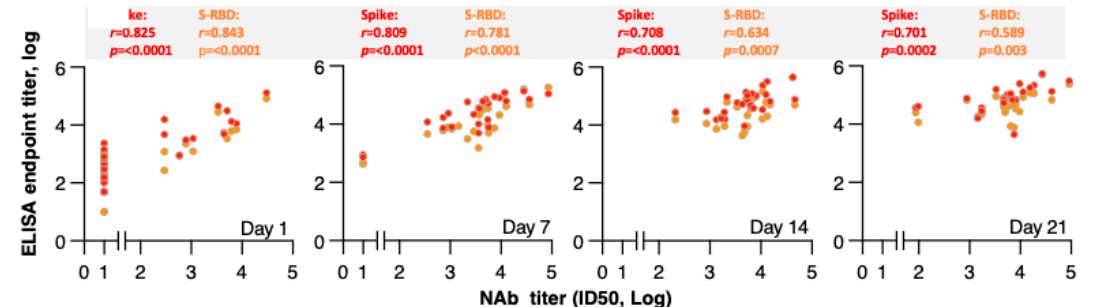
Figure 2. Correlations of the Spike and Spike-RBD binding and Neutralizing antibodies (NAb) at different time points. Correlations of reciprocal pseudotype NAb titers (ID50, log) and reciprocal endpoint titers of Spike (red symbols) and Spike-RBD (orange symbols) measured at indicated time points. Spearman r and p values are given.